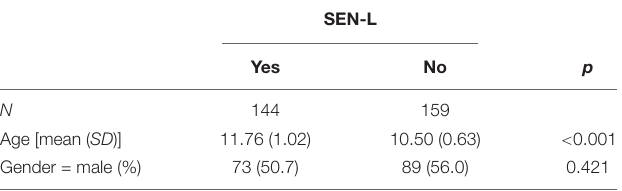
TABLE 1 | Participants gender and age stratified by